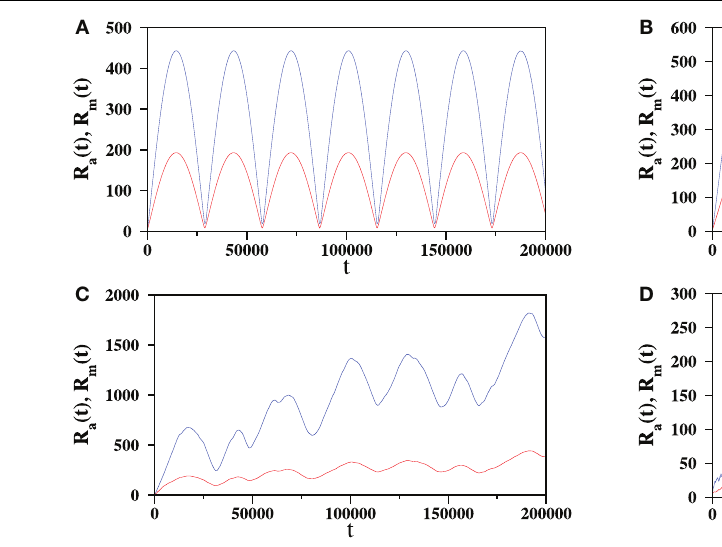
(red) have been shown with different strengths of the noise parameter: (A) η = 0, (B) 0.2, (C) 0.5, and (D) 1. The initial positions and velocities are same in all four cases.